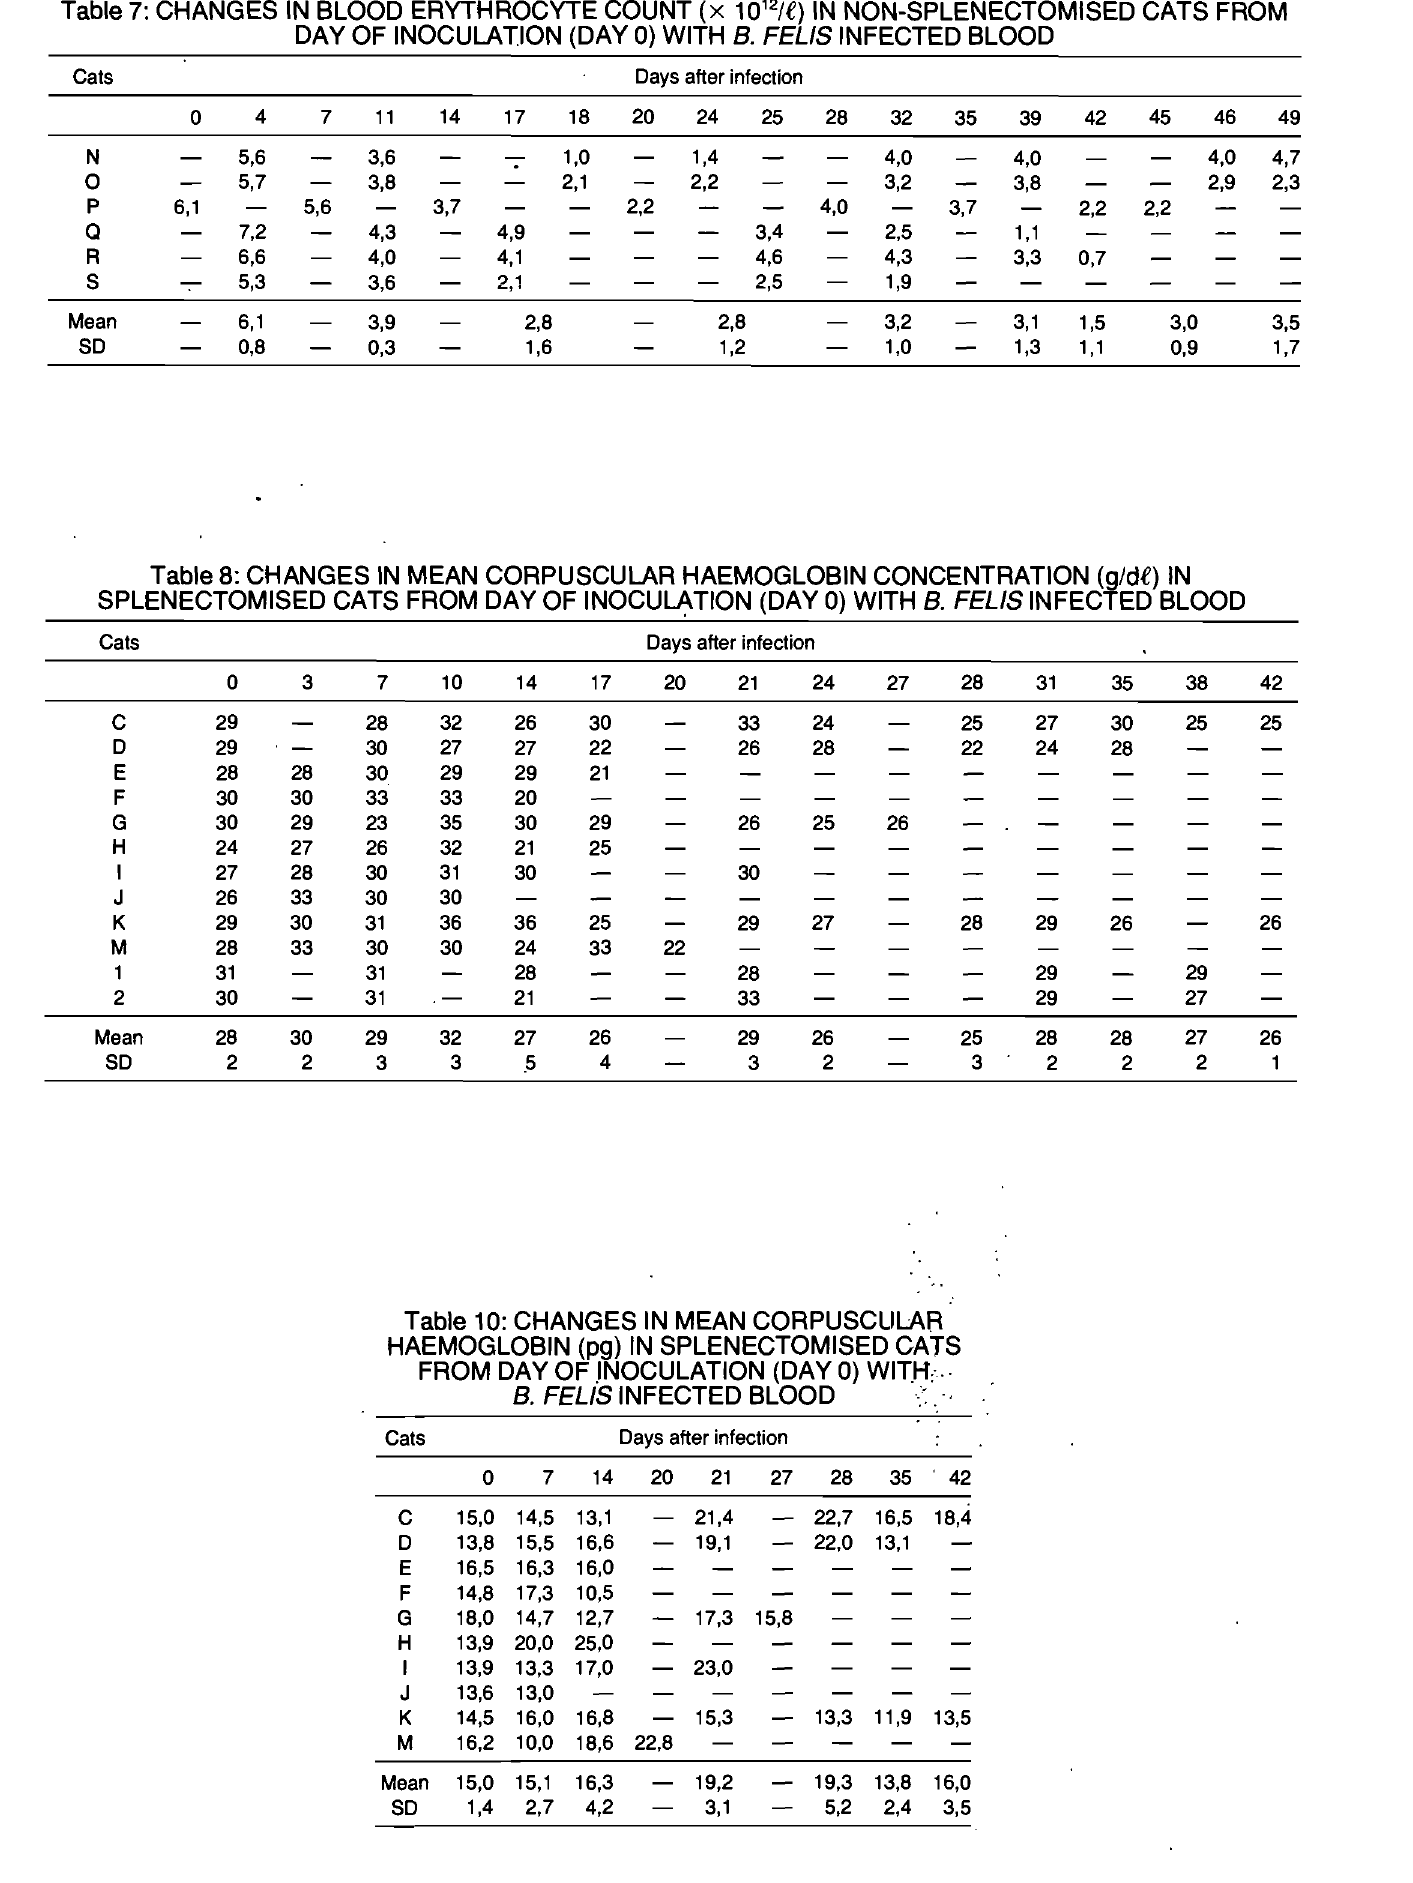
Table 10: CHANGES IN MEAN CORPUSCULAR HAEMOGLOBIN (pg) IN SPLENECTOMISED CATS FROM DAY OF jNOCULATION (DAY 0) WIT.H:.· B, FELIS INFECTED BLOOD .'.